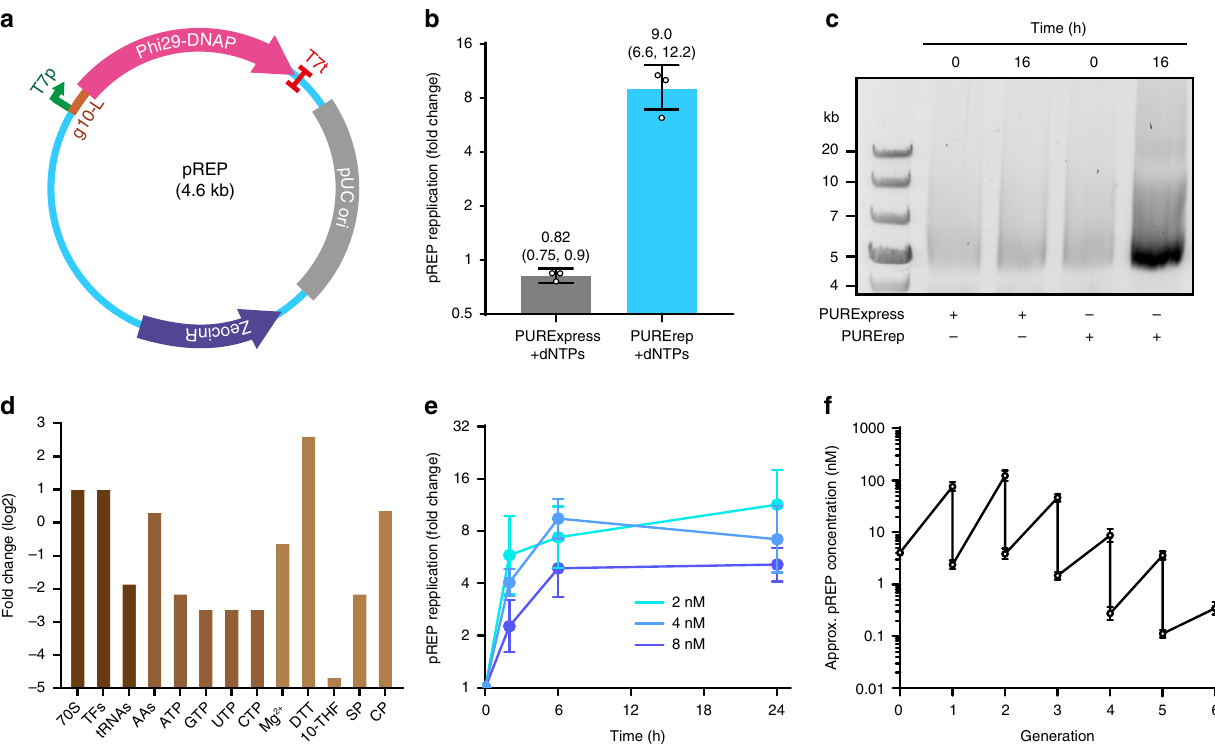
Fig. 1 PURErep enables ef fi cient transcription – translation coupled DNA replication. a Map of pREP. The plasmid encodes the gene for Phi29-DNAP under the control of a T7 promotor (T7p) and a bidirectional T7-terminator (T7t). IVT of the DNAP gene is increased by a T7 g10-L leader sequence. A zeocin-resistance gene and a pUC origin allow selective propagation in E. coli . b Replication of pREP in PURExpress (grey) or PURErep (blue) after 6 h at 30 °C. Fold changes were determined by qPCR relative to the pREP input levels (4 nM). Bars show the means with their 68% con fi dence intervals (CI)